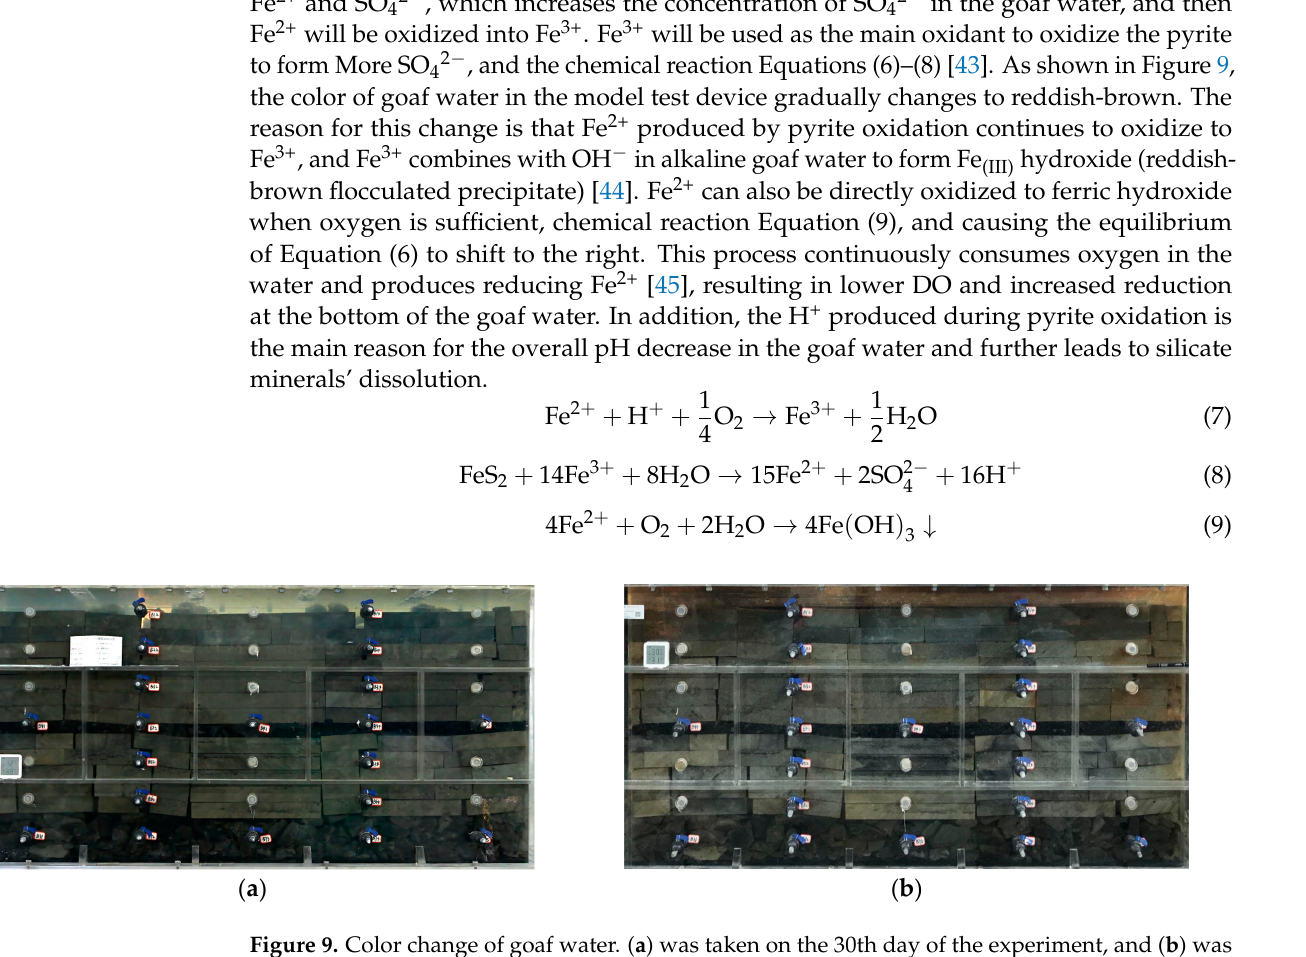
Figure 10. Variation characteristics of SRB and SOB community abundance during the experiment. Devulcanization (sulfate respiration) is the primary way SRB affects hydrochemical characteristics [48]. In this way, SRB can reduce sulfate to sulfide such as H 2 S (Sulfide) and elevate the pH of water in goaf. Microbial sulfate reduction is mainly related to enzyme catalysis encoded by Sat, aprA, aprB, dsrA, and dsrB genes [49,50]. As shown in Figure 11, the relative abundance of all sulfate-reduction-related genes increased significantly from 90 to 180 days and slowed down from 180 to 300 days, indicating that the microbial sulfate reduction was significantly enhanced from 90 to 180 days and peaked after 180